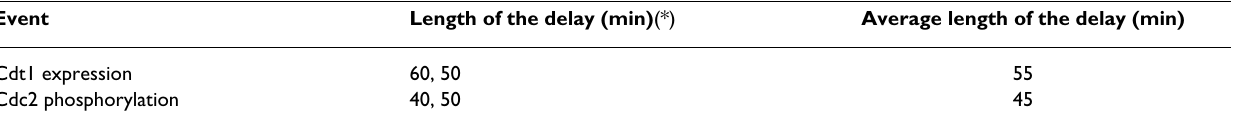
Table 2: Cdt1 expression and Cdc2 phosphorylation are delayed upon UV irradiation Event Length of the delay (min) (*) Average length of the delay (min) Cdt1 expression 60, 50 55 Cdc2 phosphorylation 40, 50 45 (*) The levels of Cdt1 expression and Cdc2 phosphorylation were quantified and the length of the delay was measured at the point where Cdt1 expression and Cdc2 phosphorylation, respectively, reached 50% of its maximal value. Irradiations were carried out 3.5 hours after inoculation in